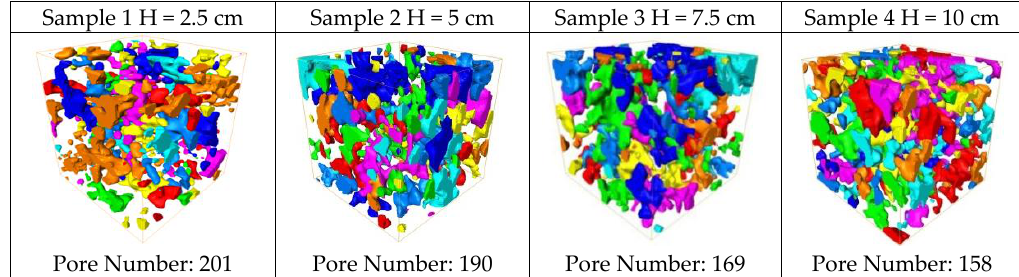
Figure 7. Pore separation model in the tailings bed.